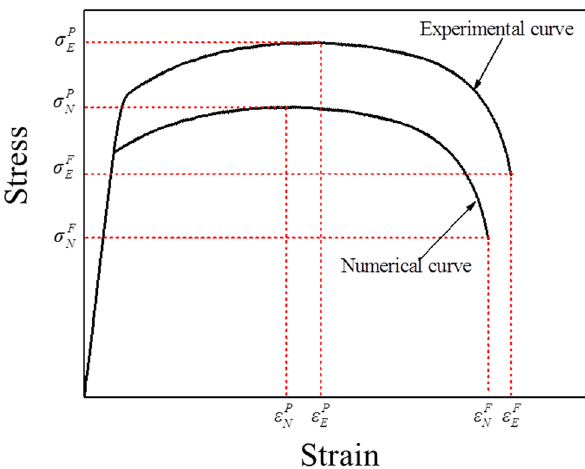
Figure 2: Schematic description of the related indicators in the response variables of